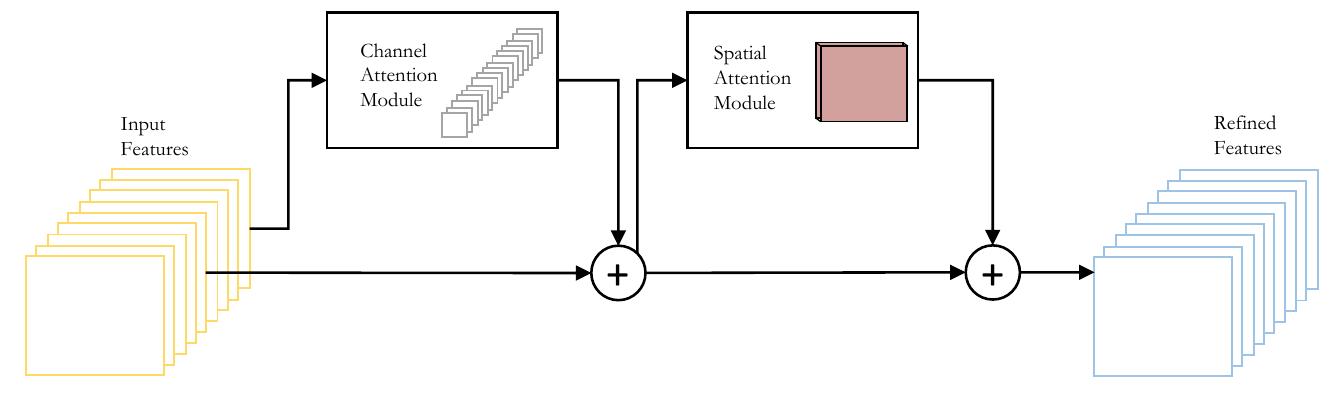
Figure 3. Overview of the CBAM